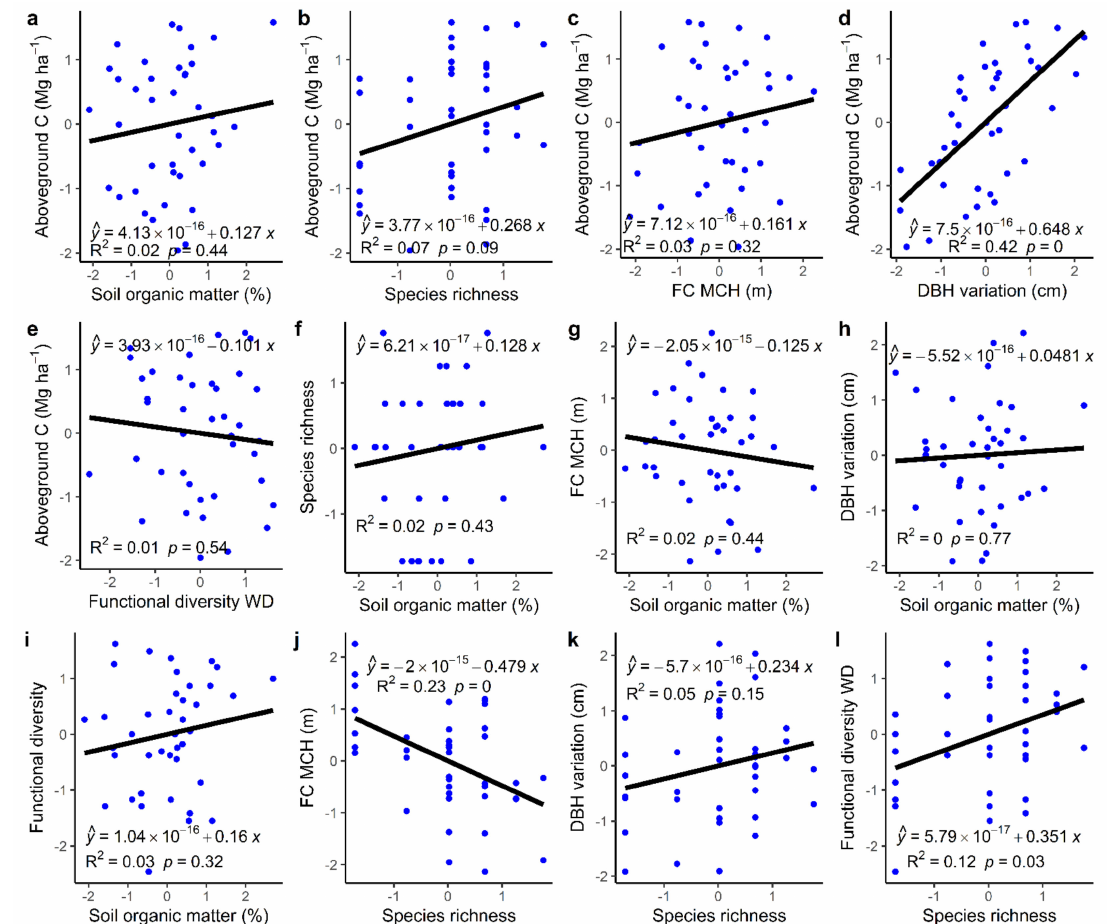
Figure 2. Bivariate relationship between predictors and response variables (all the direct paths of structural equation model in Figure 3). All the data were log transformed and standardized mean zero and one standard deviation. ( a – e ) Aboveground biomass carbon vs. soil organic matter ( a ), species richness ( b ), functional composition of maximum canopy height (FC MCH; ( c )), variation of diameter at breast height (DBH at 1.37 m; ( d )) and functional diversity of wood density (FC WD), respectively. ( f – i ) The effects of soil organic matter on species richness, FC MCH, variation of DBH and FC WD, respectively. ( j – l ) The effects of species richness on FC MCH, variation of DBH and FC WD,